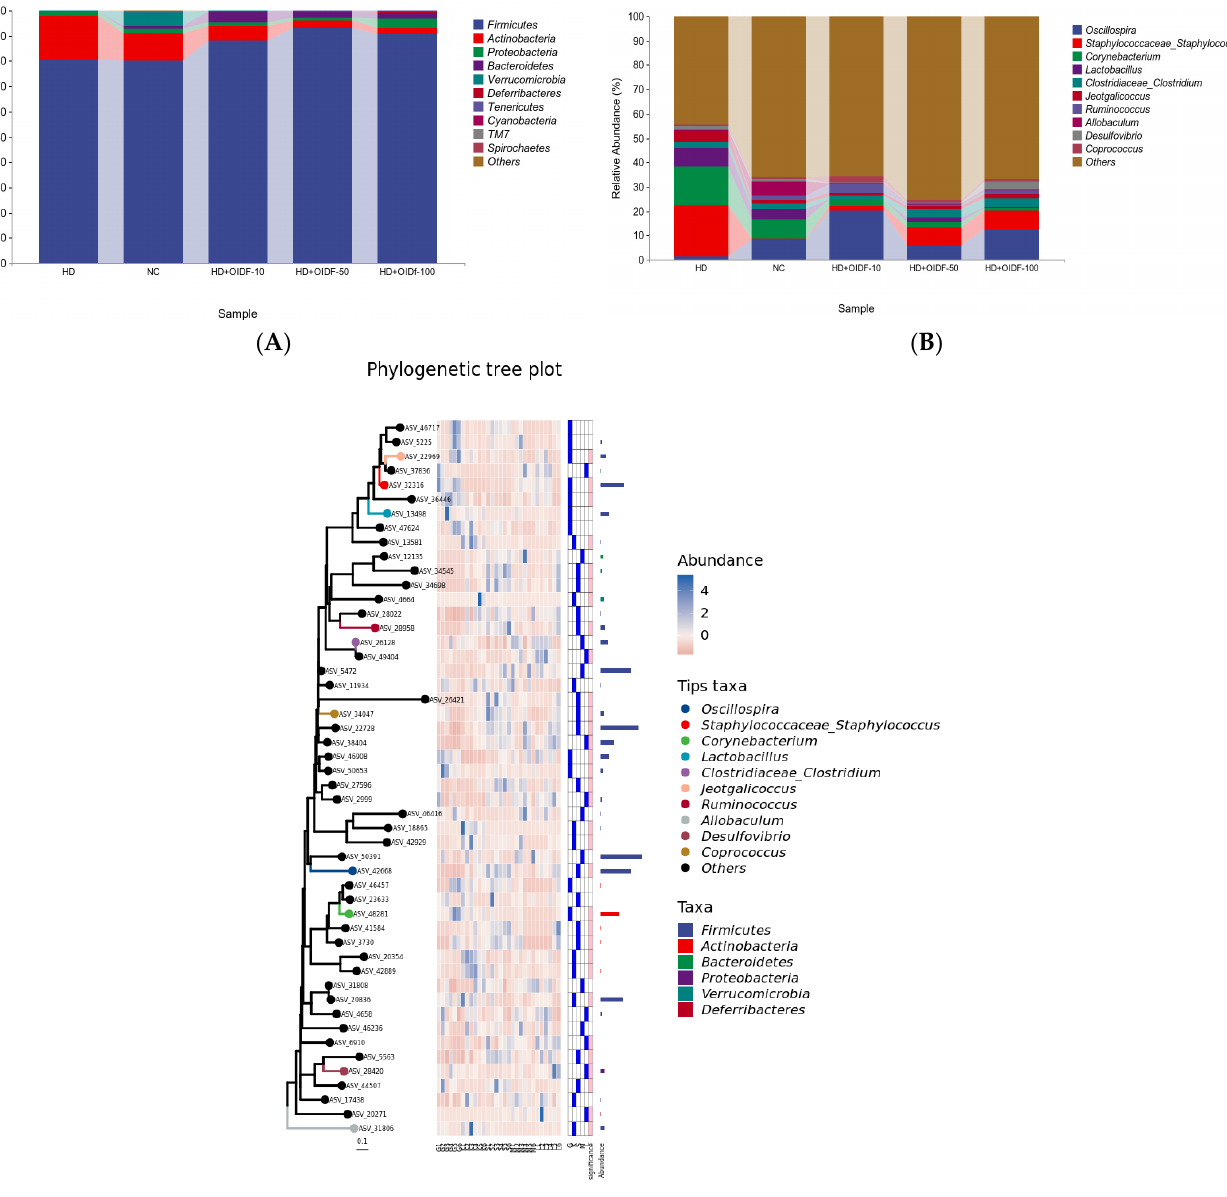
Figure 6. Bacterial composition analysis between different populations: ( A ) t phylum level; ( B ) genus level; ( C ) Species composition analysis.